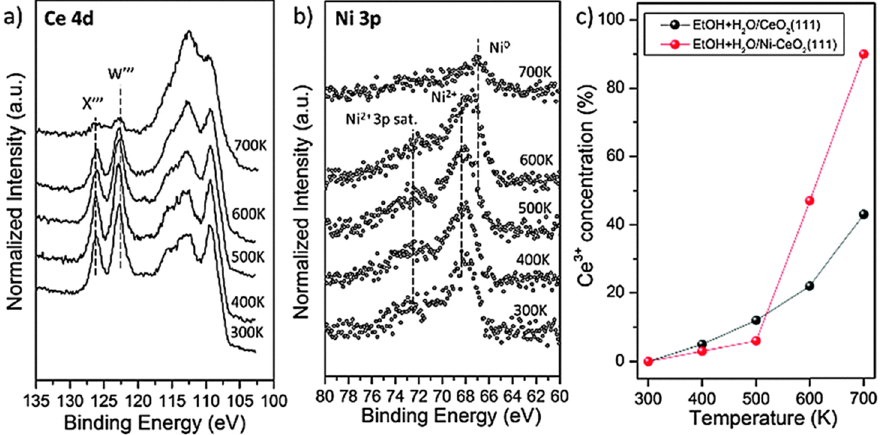
Figure 7. ( a ) Ce 4d and ( b ) Ni 3p spectra of Ni / CeO 2 (111) surface under SRE conditions, and ( c ) surface Ce 3 + concentration comparison between CeO 2 (111) and Ni / CeO 2 (111) catalysts. Reprinted with permission from [154], copyright 2016, Royal Society of Chemistry.